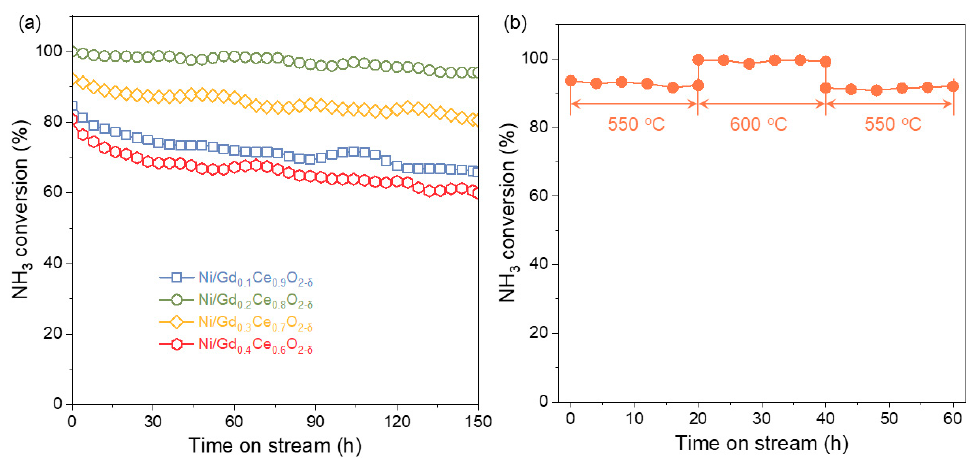
Figure 6. Ammonia conversion as a function of time ( a ) over the course of 150 h and ( b ) at 550–600 °C.